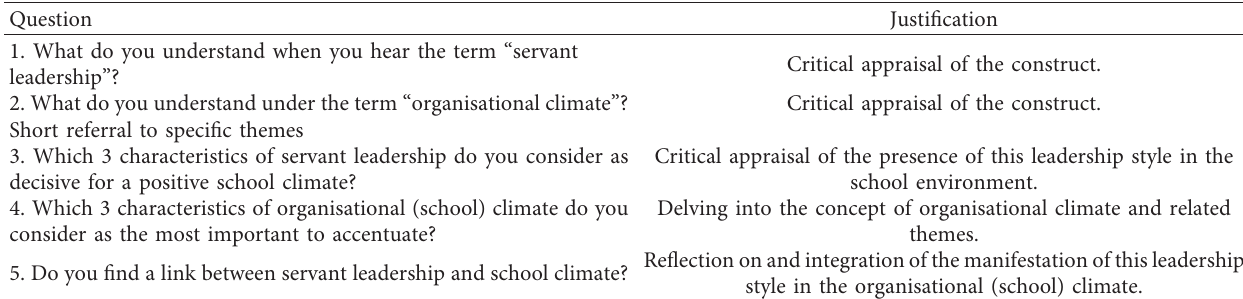
Table 1: Specific questions and justification of